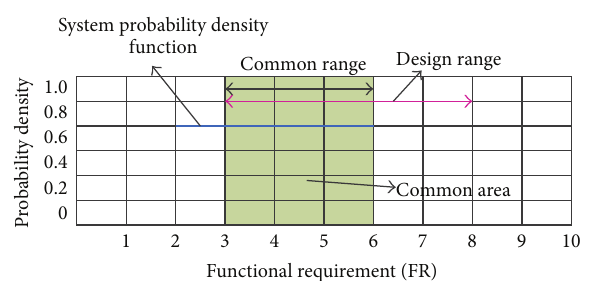
Figure 3: The probability of success for a one-FR, one-DP design [2].